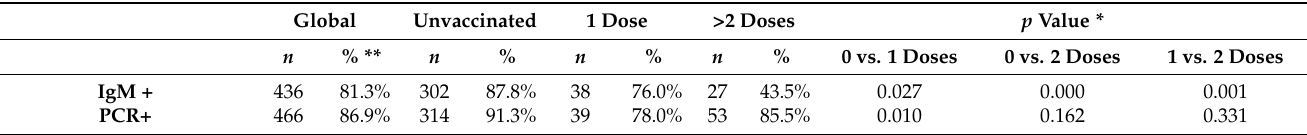
Table 6. Laboratory performance for measles cases with both samples (serum and throat swab/urine). Spain, 2014–2020.